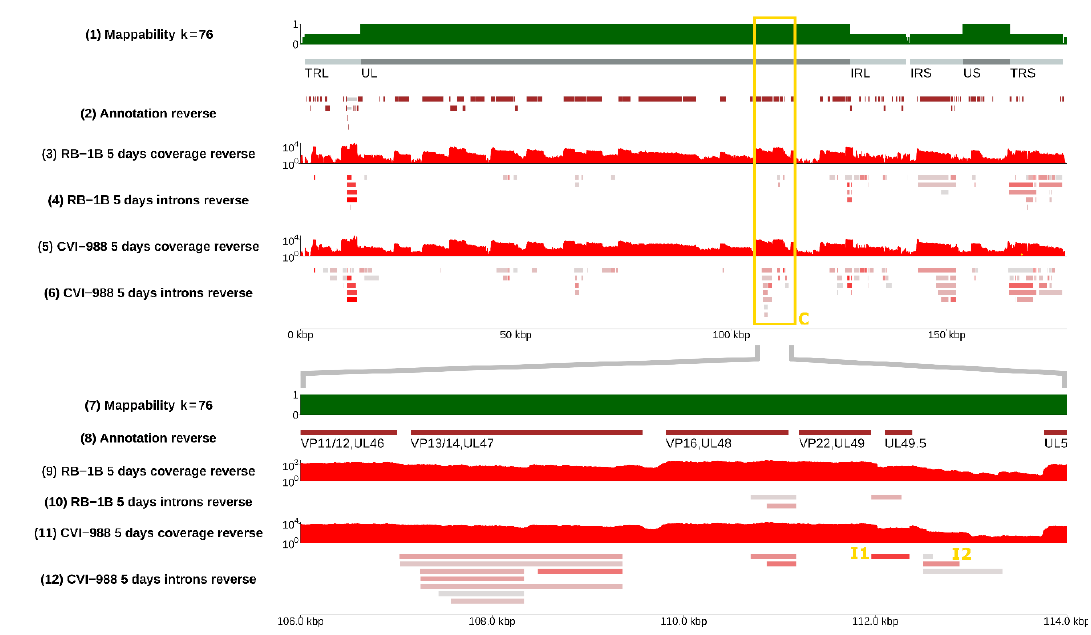
during its infection of CEF cells – track (9) – the complexity of the splicing landscape in the same region was vastly superior in CVI-988, which showed several times more introns being actively spliced – track (11). Intron I3, which is one of the several expressed in CVI-988 and not in RB-1B, is highlighted with a yellow arrow in the bottom panel . The bottom panel of this figure can be reproduced in the online MDV genome browser by accessing https: // mallorn.pirbright.ac.uk / browsers / MDV-annotation / Figure-3.html.